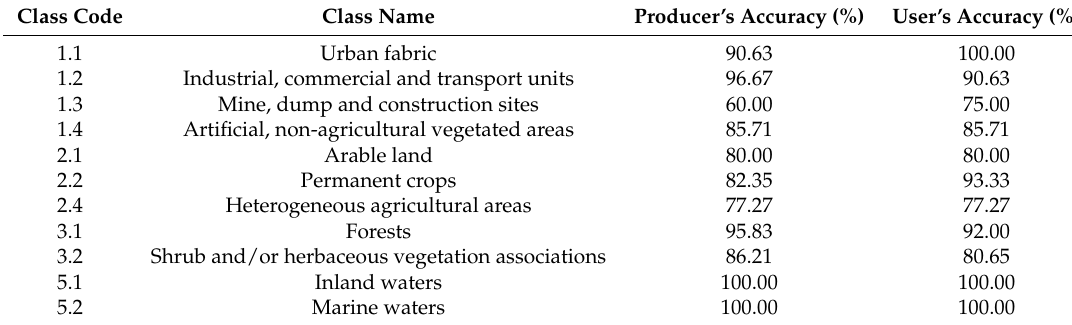
Table 7. Accuracy assessment results of Level 2 classes.